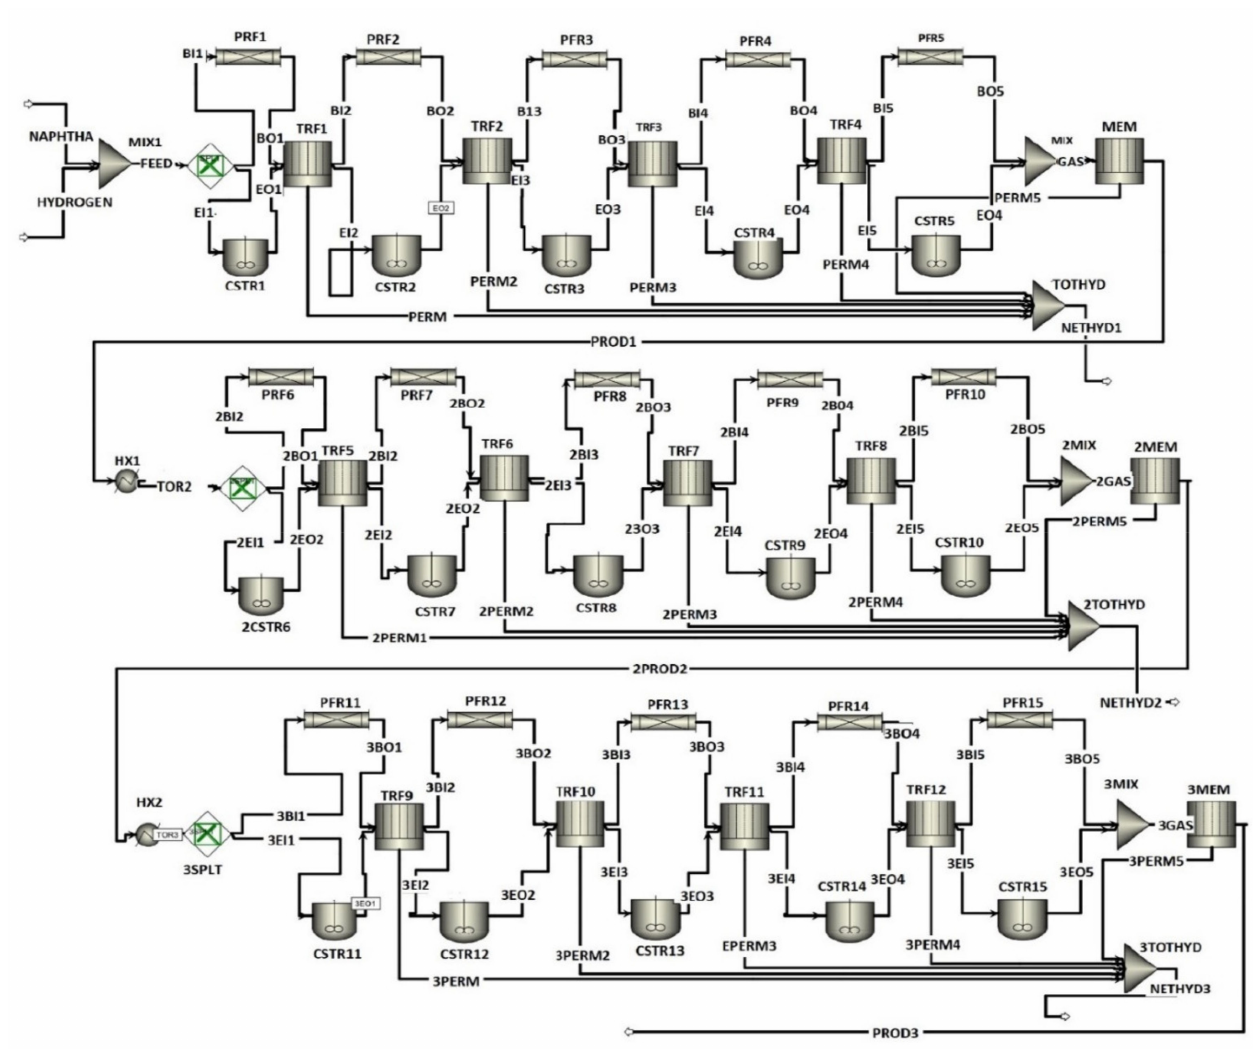
Figure 6. Process flow diagram of